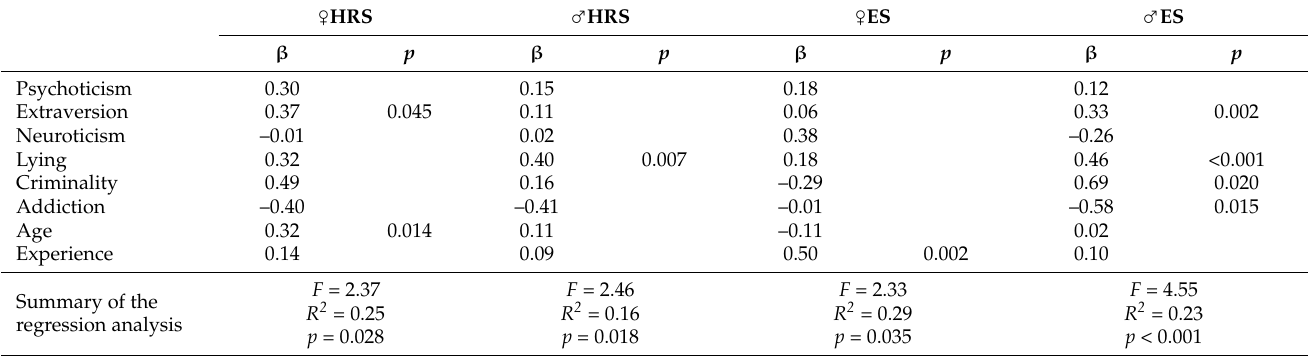
Table 1. Summary of the regression analysis: personality features and satisfaction with life.